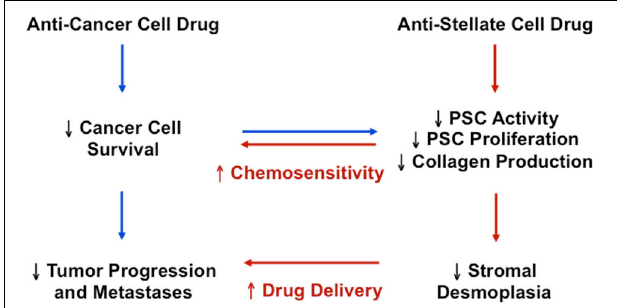
FIGURE 3 | The potential therapeutic implication of targeting both pancreatic cancer cells and pancreatic stellate cells in pancreatic